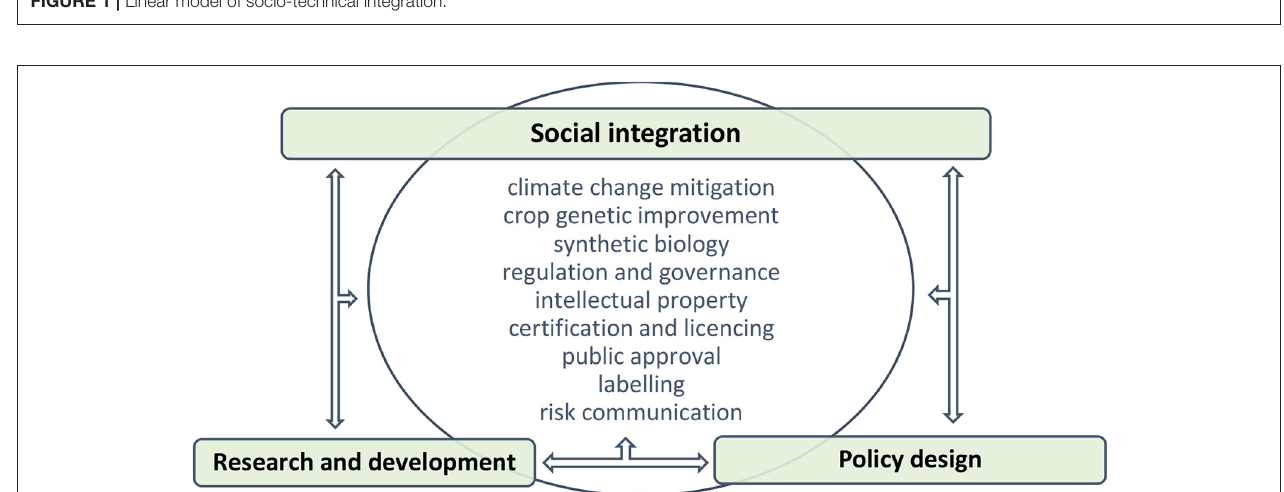
FIGURE 1 | Linear model of socio-technical integration.